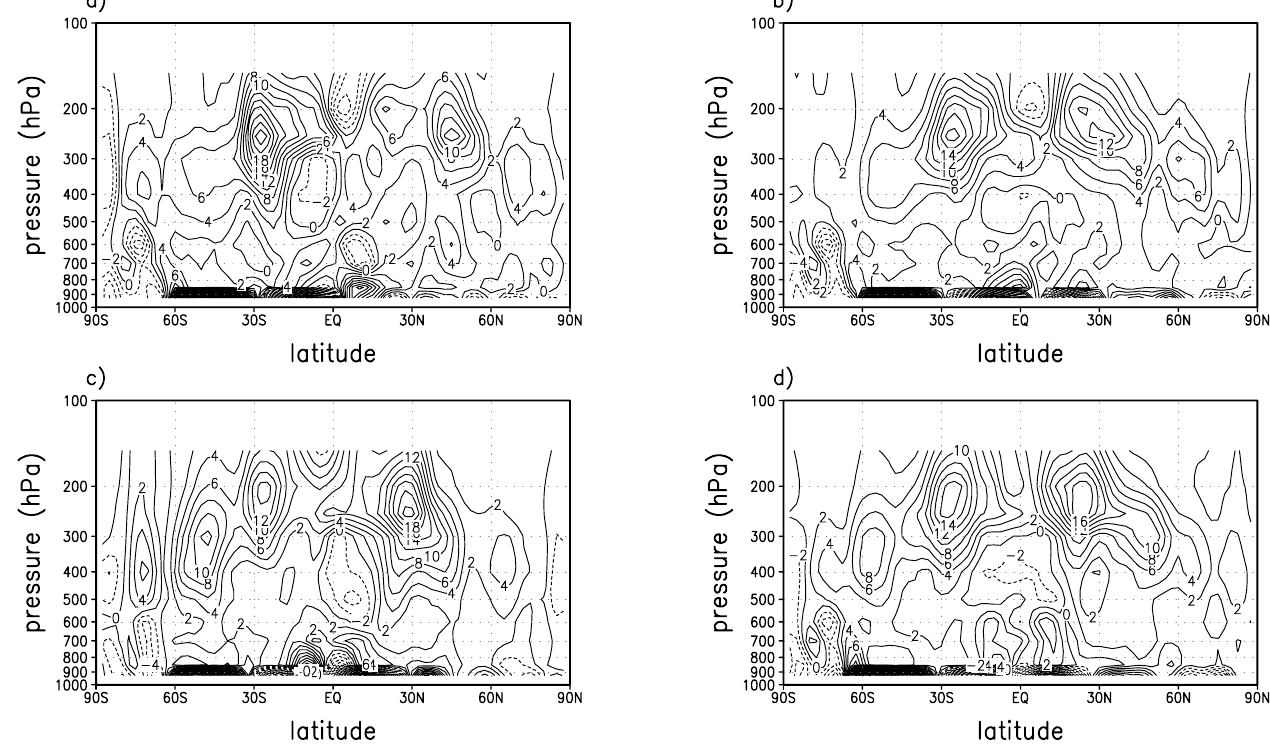
Fig. 4. Same as Fig. 3 but for (a) July 1997, (b) October 1997, (c) January 1998 and (d) April